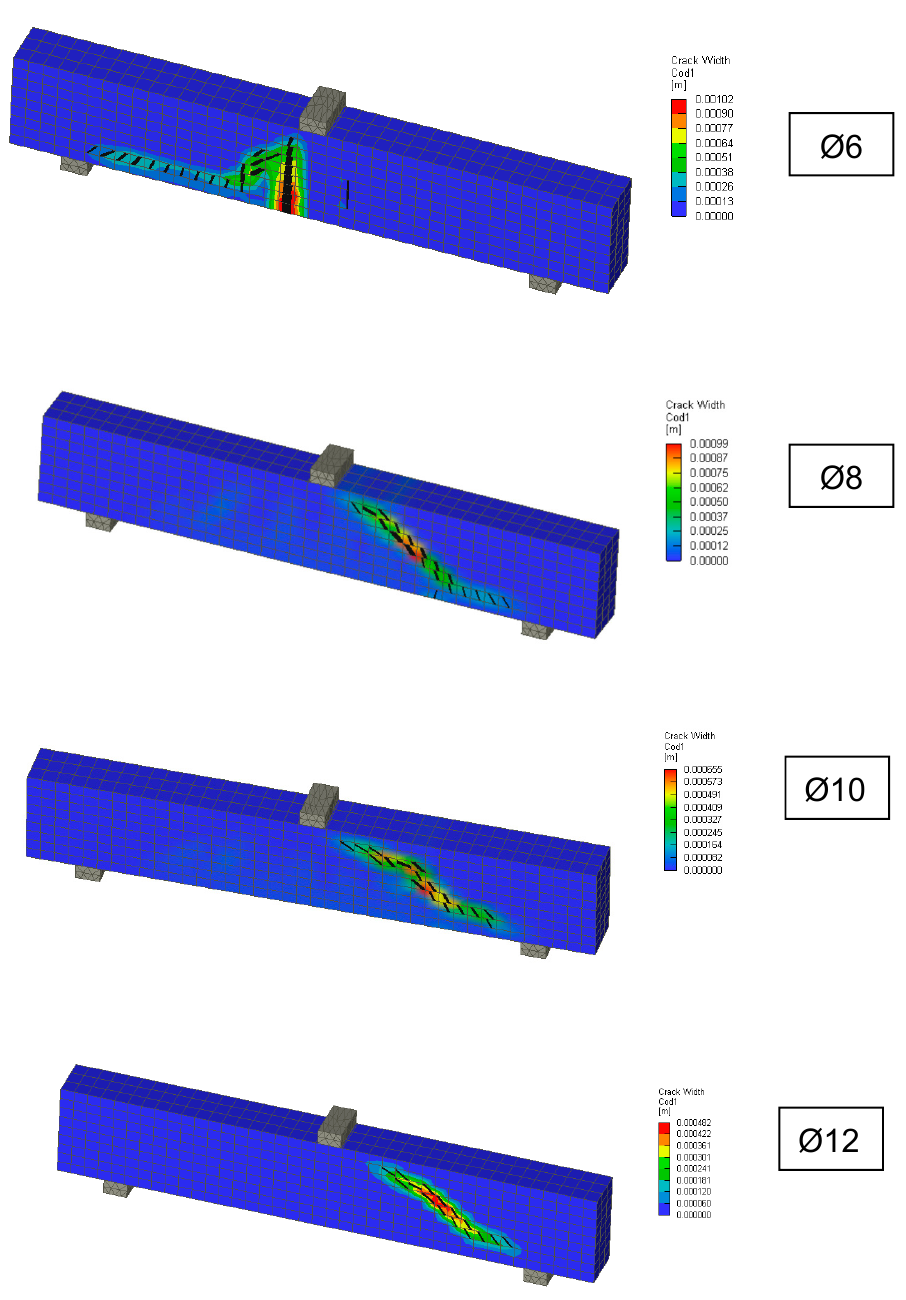
Figure 13. Reinforced concrete beams without transverse reinforcement—3D models with crack (min. 0.2 mm).